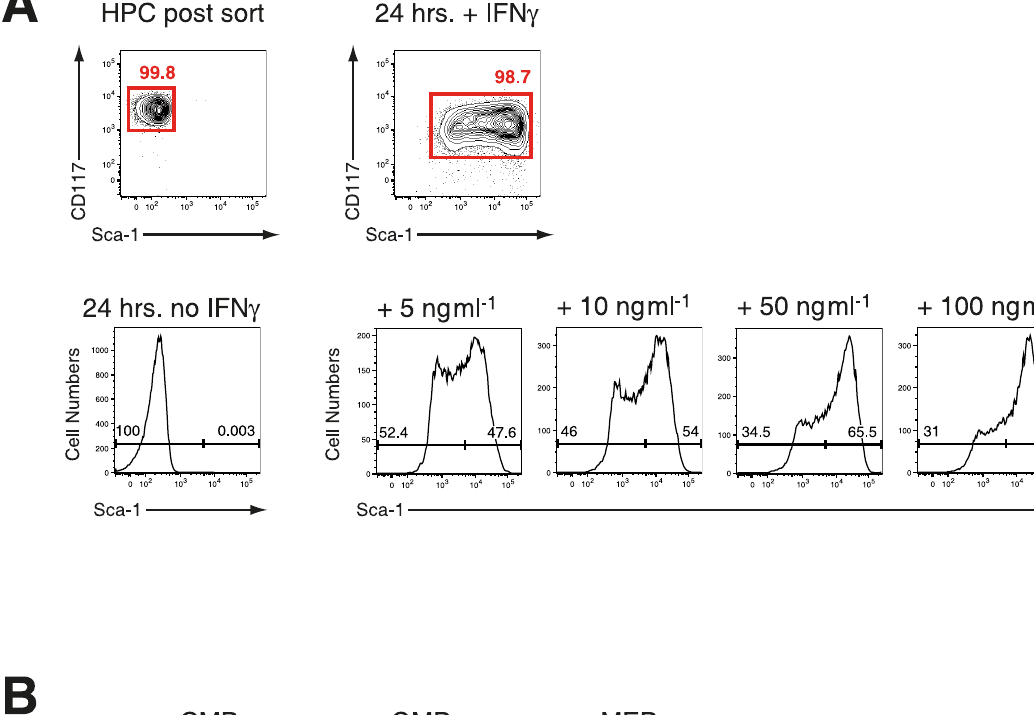
Conversely only the latter showed the capacity to produce erythroid cells, which was completely absent in the two myeloid subsets. These results demonstrate that the transient reduction of